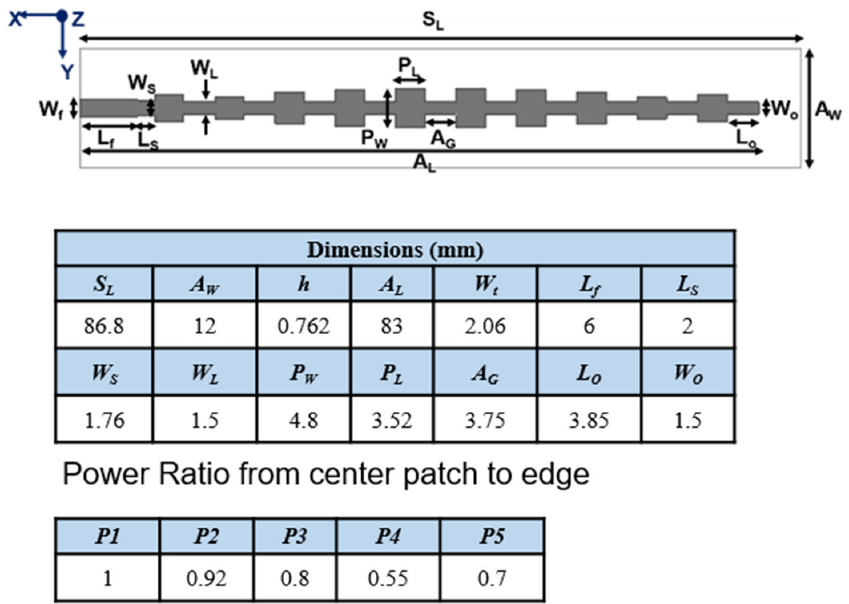
Figure 1. Antenna geometry and dimensions.